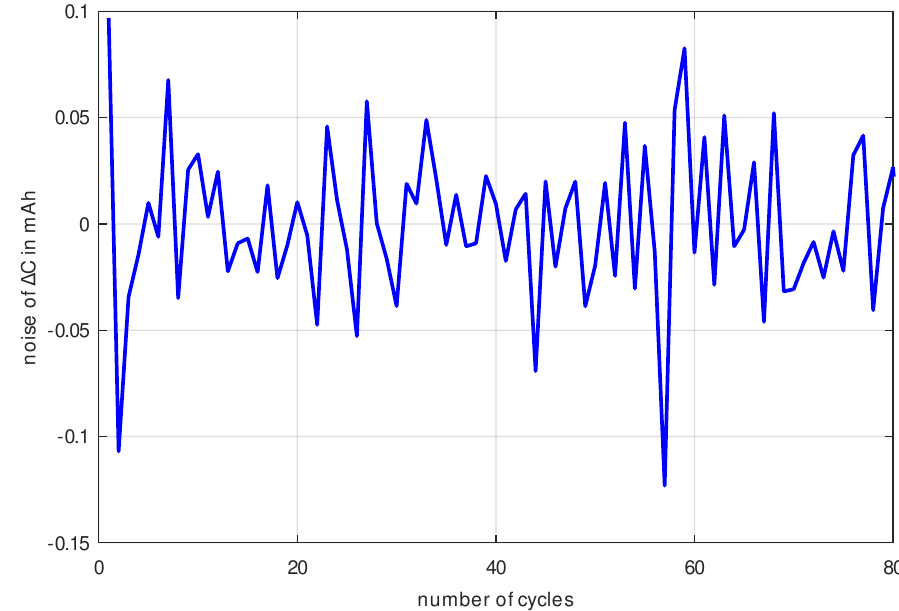
Figure 7. Noise of the delta capacity measurement of Figure